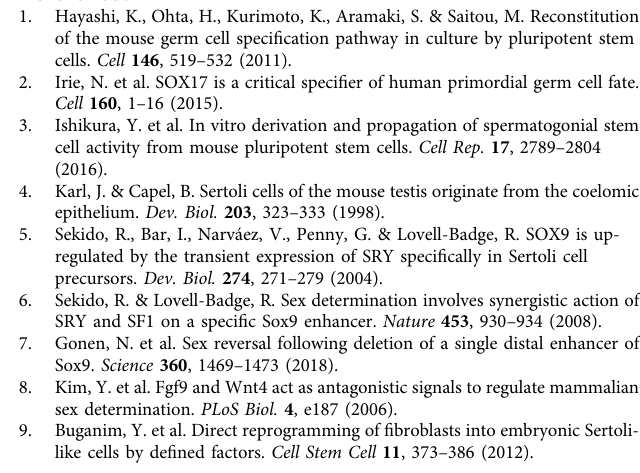
Enzyme-linked immunosorbent assay . Testosterone was extracted from culture media using a protocol provided by Testosterone ELISA kit (Enzo Life Sciences). Brie fl y, 400 μ l of culture media were mixed with 400 μ l of diethyl ether and left for 5min to allow layers to separate. The upper ether supernatant was transferred to